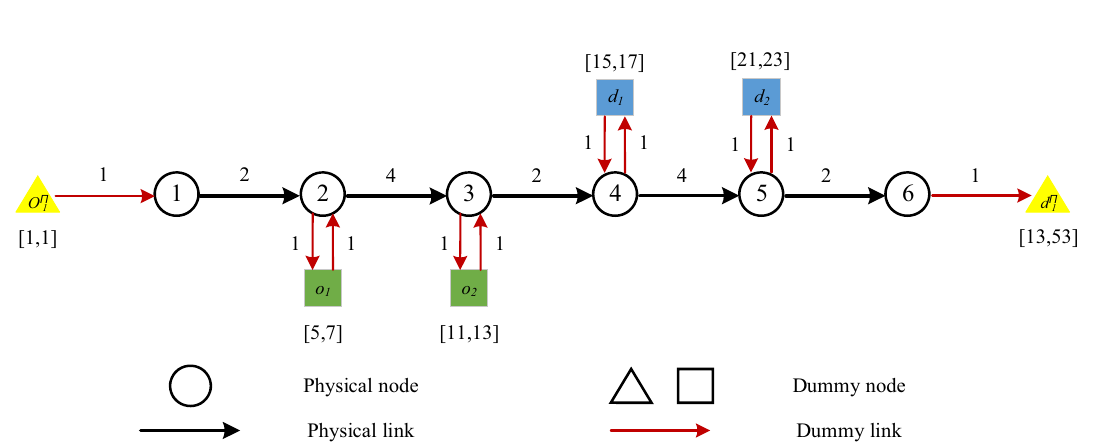
Fig. 8 Vehicle space–time trajectory for the basic example